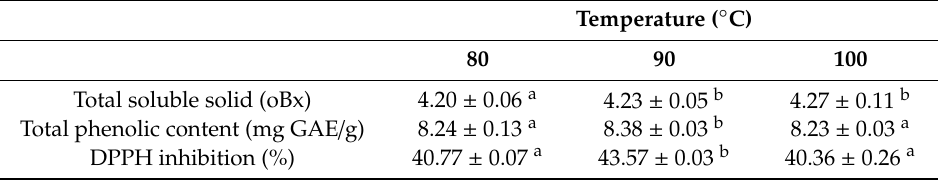
Table 3. E ff ects of brewing water temperature on the characteristics of the Roselle tea.